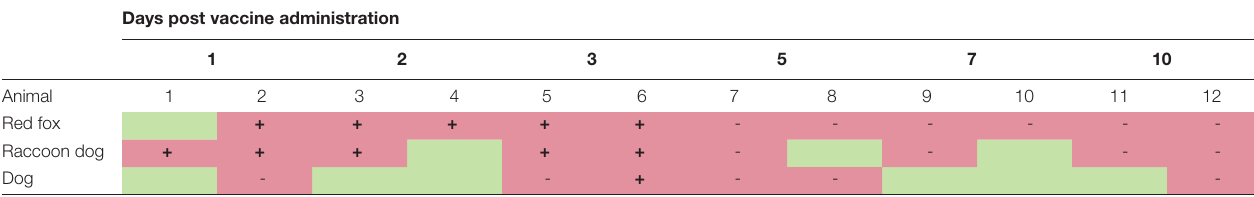
taBle 2 | presence of viral RNA (PCR) and infectious virus (RTCIT) in the palatine tonsils of red foxes, raccoon dogs and dogs (green, PCR-negative; red, PCR- positive; +, RTCIT positive; -, RTCIT-negative).